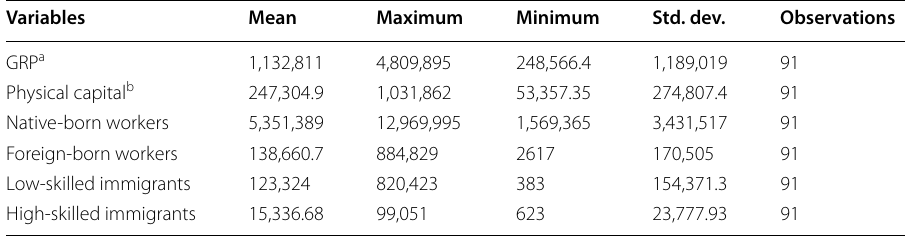
a, b Millions of baht unit